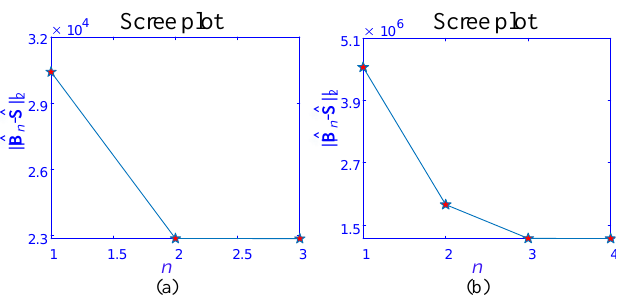
Figure 4. The scree plot of the simulation data. ( a ) is for Figure 2; ( b ) is for Figure